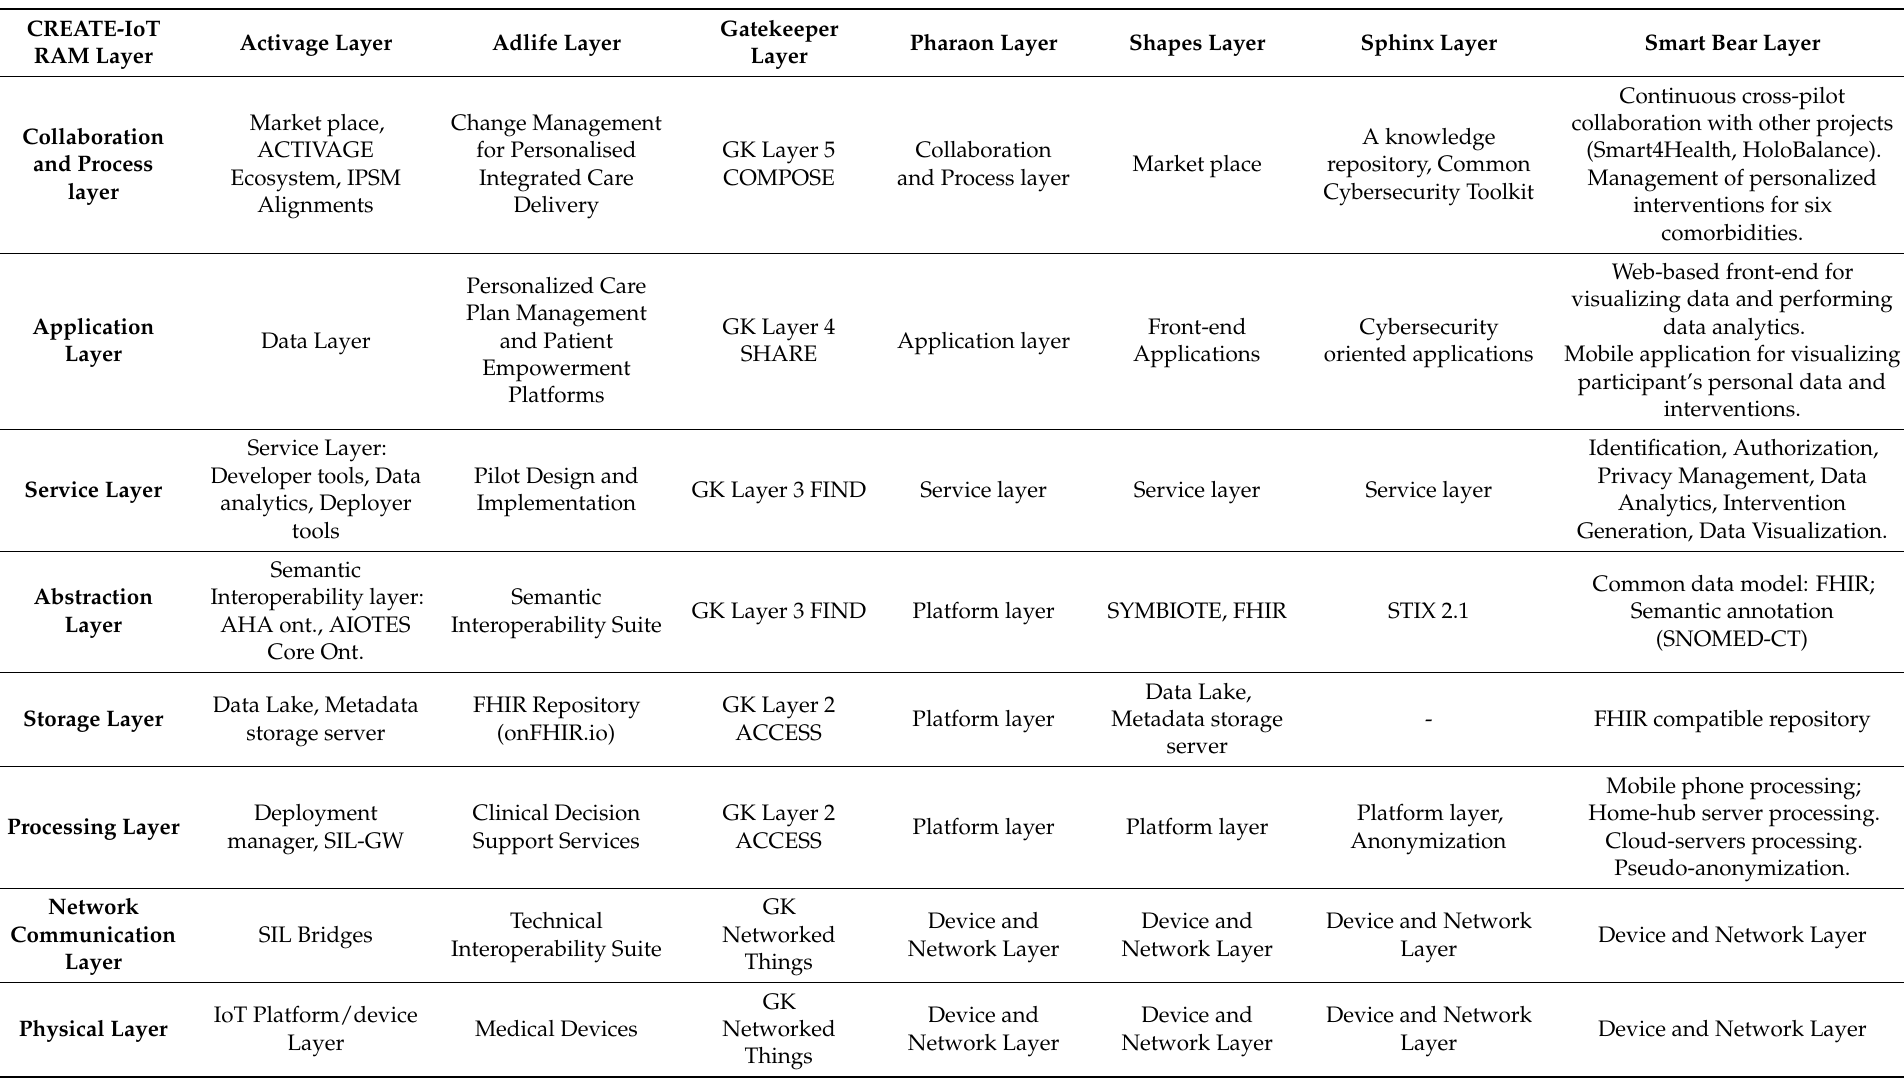
Table 4. Projects’ architectures mapped to CREATE-IoT 3D RAM